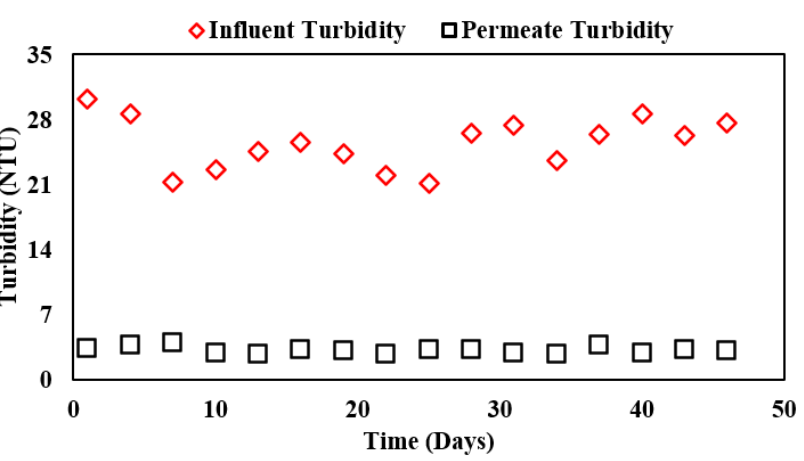
Figure 5. Influent and effluent turbidity concentrations in ABR-AF coupled membrane system dur- ing Phase III. Phase